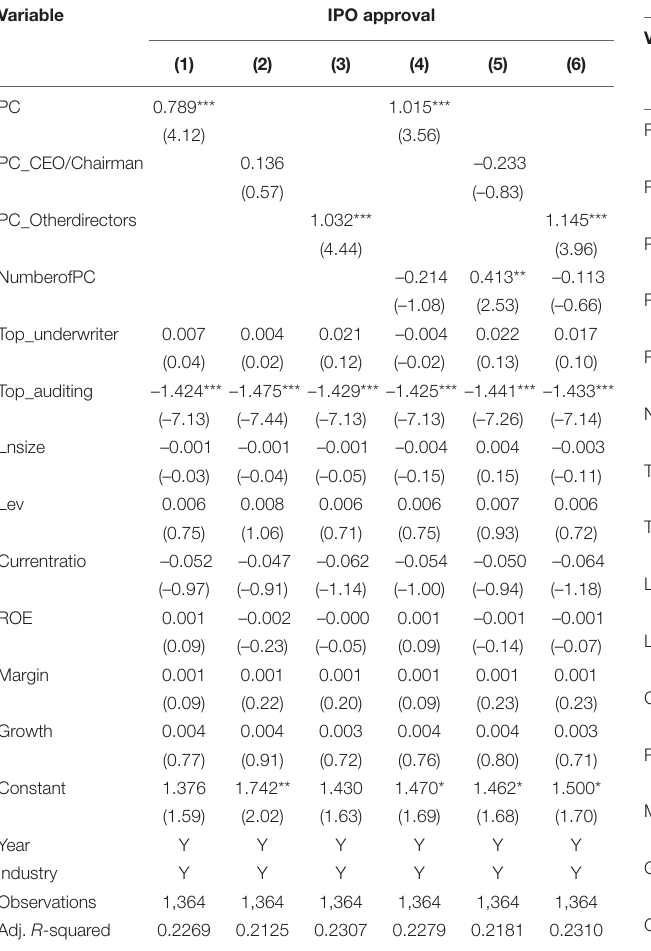
TABLE 5 | The impact of political connection on IPO approval. TABLE 6 | The impact of Registration System on the association between political connection and IPO